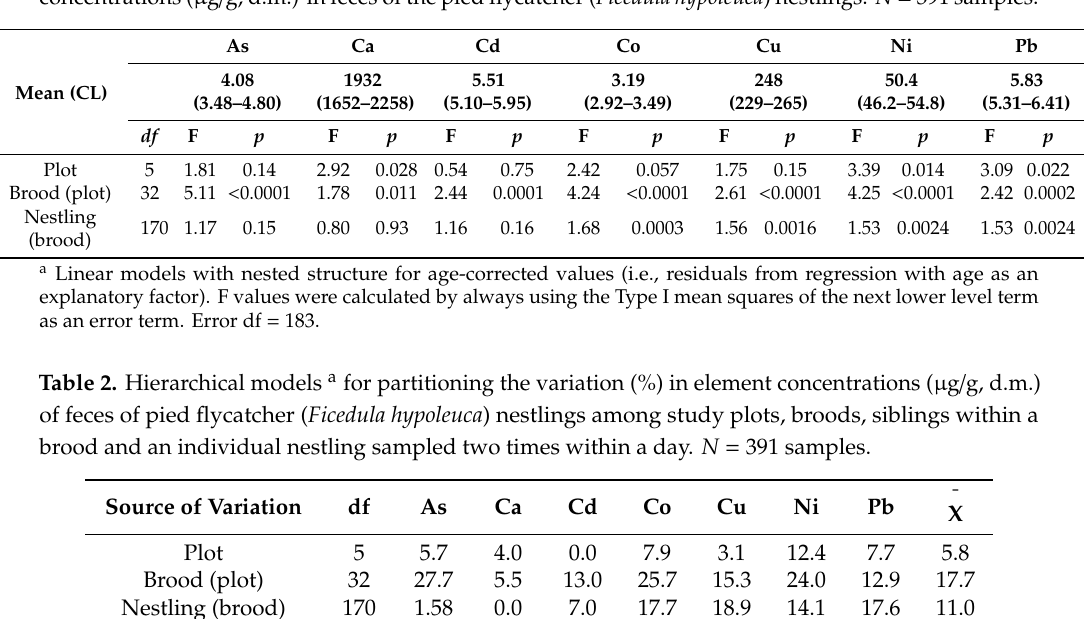
Table 1. Geometric means ( ± 95% confidence limits) and hierarchical linear models a for element concentrations ( µ g / g, d.m.) in feces of the pied flycatcher ( Ficedula hypoleuca ) nestlings. N = 391 samples. As Ca Cd Co Mean (CL)